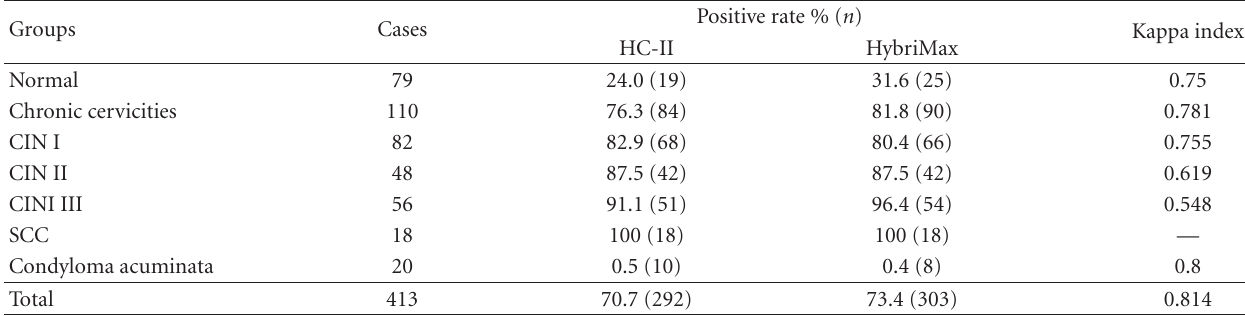
Table 1: Correlation between HybriMax and HC-II in detecting HPV DNA.